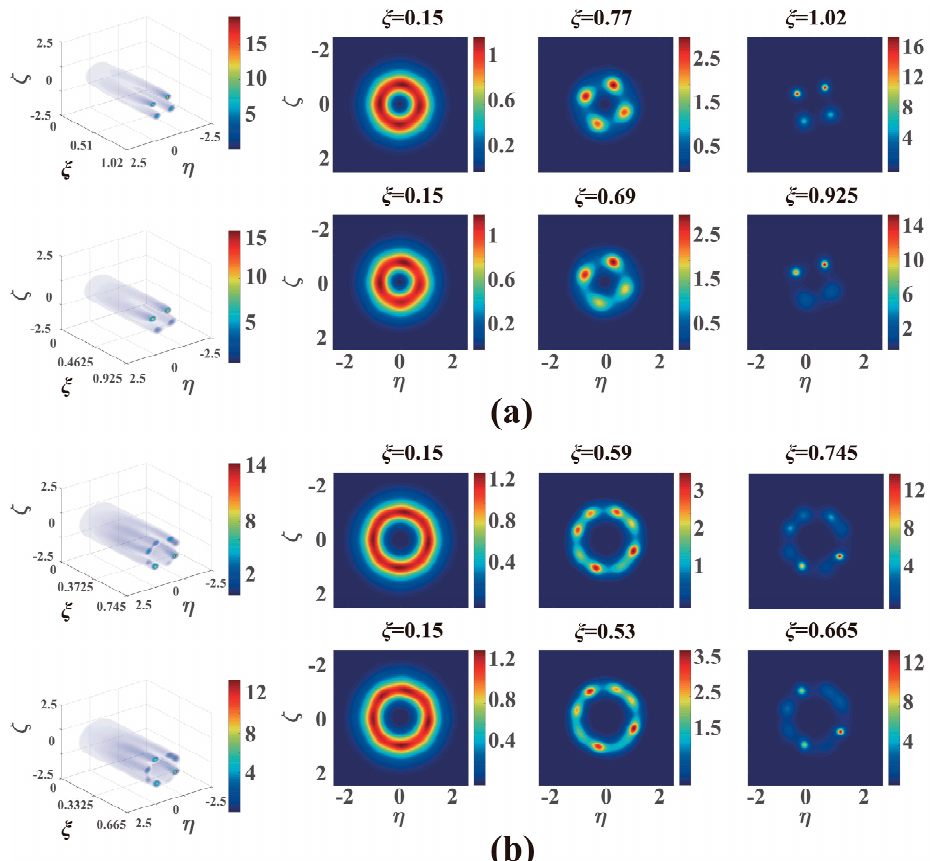
Figure 4. The evolution of vortex optical fields in the Kerr ‐ SCPT medium with different modulation depths of gain ‐ loss W 0 . Here, V 0 = 1, d = 0.31: ( a ) n = 1, P in = 1.7 P cr with W 0 = 0.15 ( upper row ) and W 0 = 0.45 ( lower row ). ( b ) n = 2, P in = 1.4 P cr with W 0 = 0.15 ( upper row ) and W 0 = 0.45 ( lower row ). The spatial evolutions of the vortex beams in the Kerr ‐ SCPT medium are shown in the first plots in each panel.